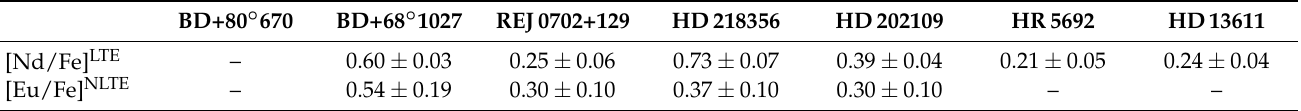
Table 5. The Nd and Eu abundances of our sample